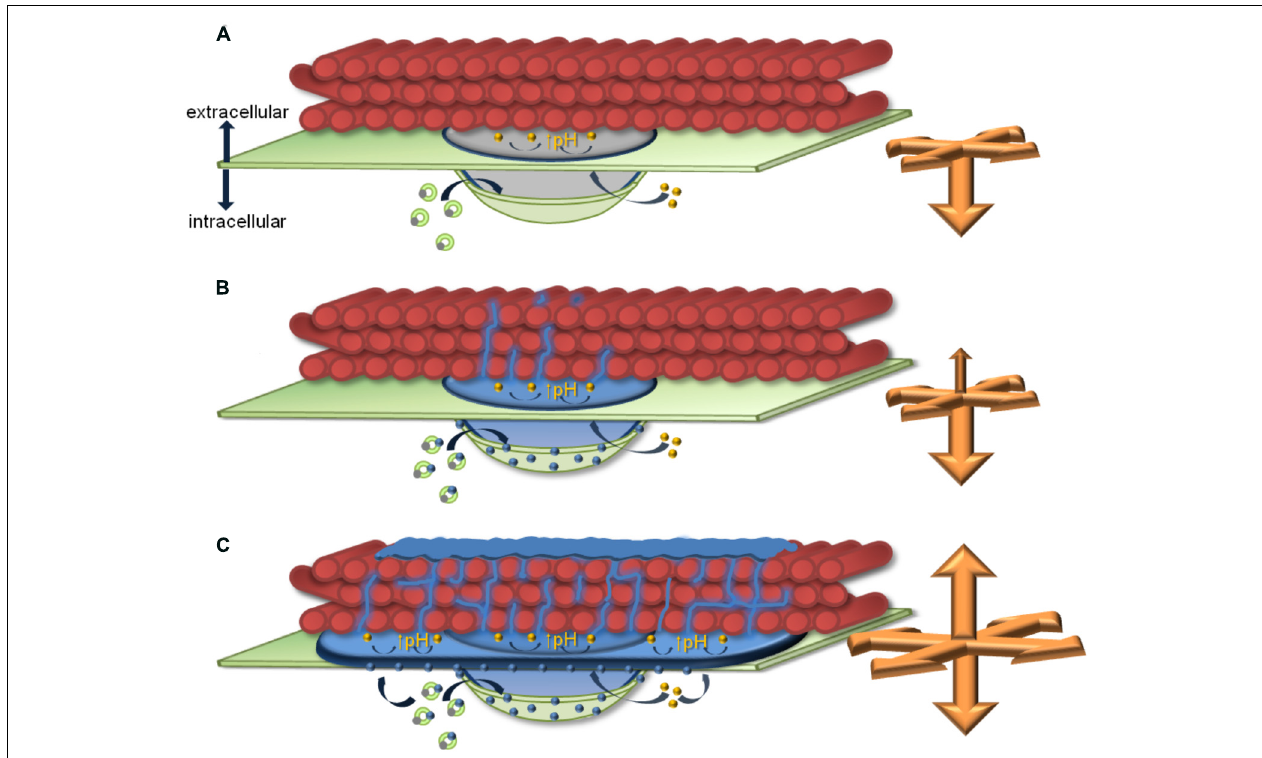
papilla-forming enzymes (gray dots) and the callose synthase PMR4 (blue dots) to the forming papilla. Yellow dots inside the papilla matrix indicate a putative involvement of vesicles/vesicle-like bodies in regulating the pH at the interphase of the papilla matrix and the cellulosic cell wall to induce gel-formation of callose ( ↑ pH). Orange arrows indicate the direction and strength of papilla expansion. Green: plasma membrane, red: cellulose fibrils of the cell wall, blue: callosic papilla matrix and callose fibrils, gray: non-callosic papilla